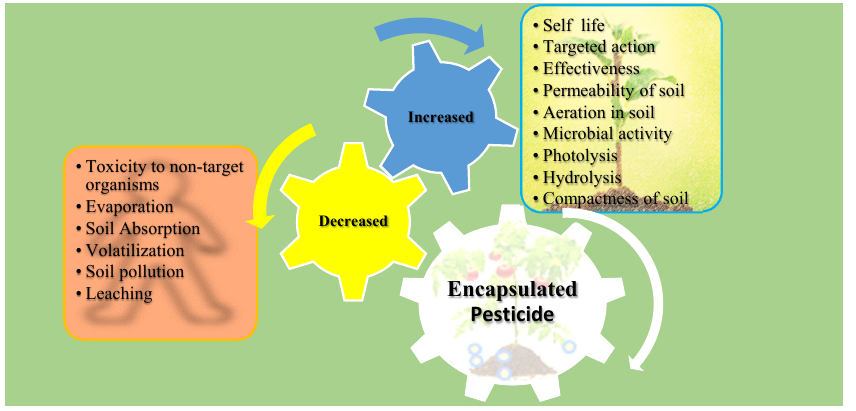
Figure 3. Impacts of pesticides encapsulated in biopolymeric NPs on soil, organisms, and the envi- ronment.